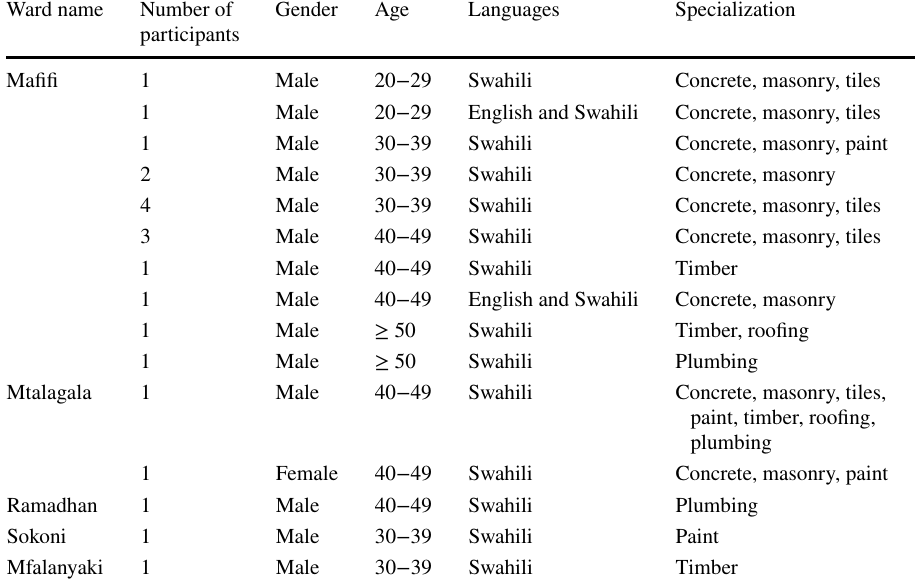
of the 21 mason survey participants in Iringa,